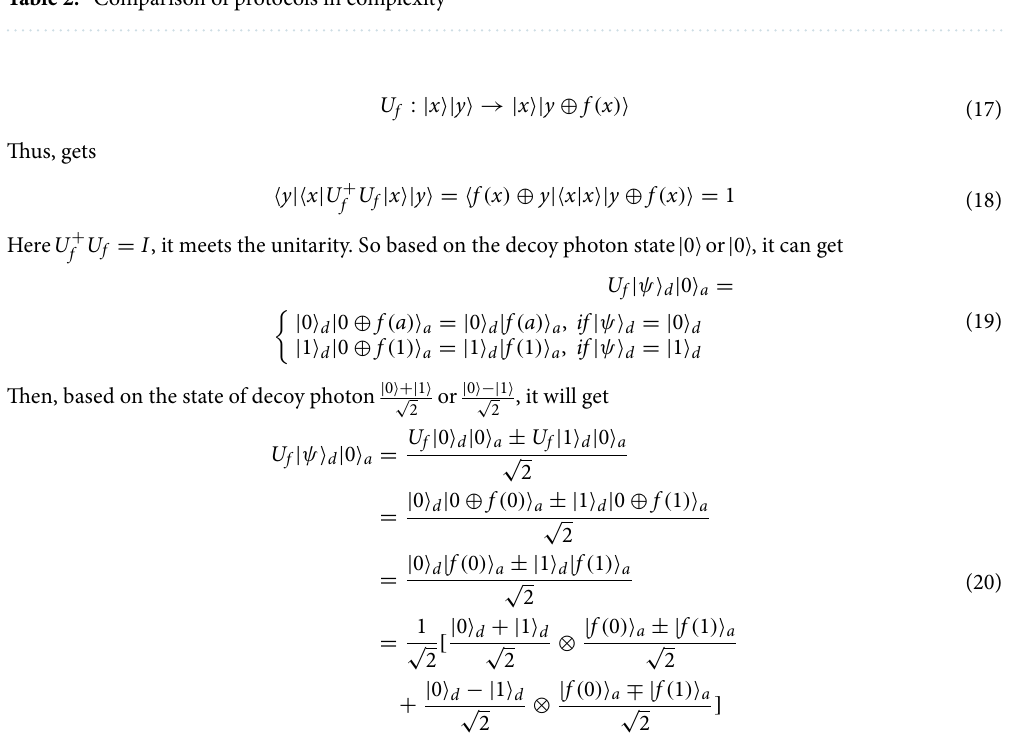
Table 2. Comparison of protocols in